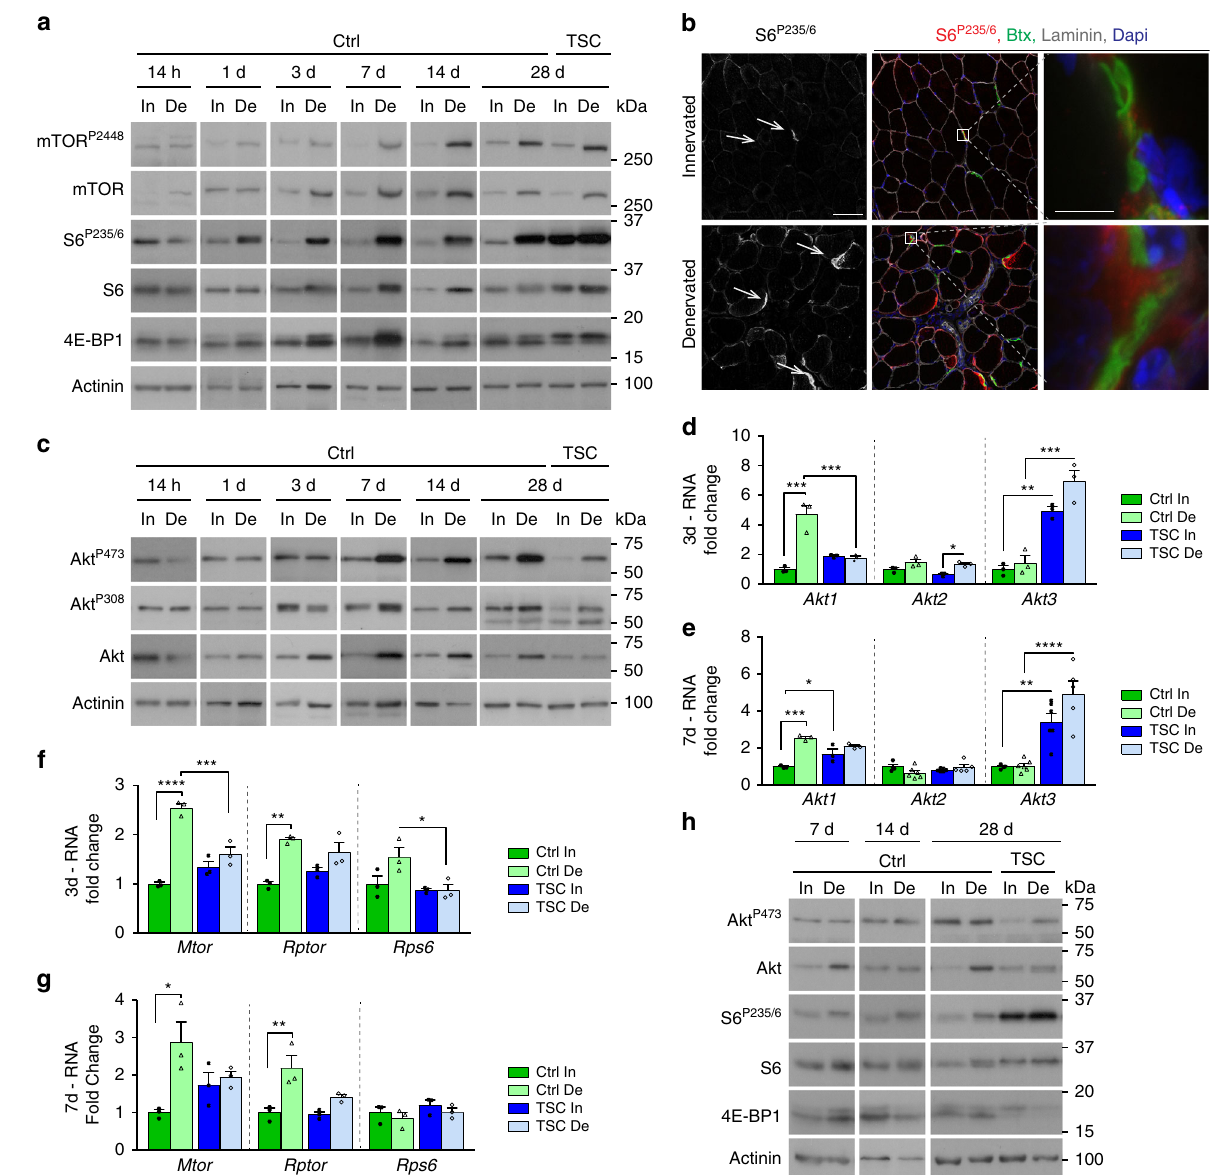
Fig. 1 The PKB/Akt-mTORC1 branch is induced upon denervation in TA muscle. a Western blot analysis of mTORC1 signaling in control (Ctrl) and TSCmKO (TSC) TA innervated (In) and denervated (De) muscles. Actinin was used as loading control. Representative image of 4 (14 h, 1d) and 3 (3 to 28d) Ctrl and 3 TSCmKO mice. b Confocal images of S6 P235/6 (red), laminin (gray), α -bungarotoxin (green) and Dapi (blue) in TA innervated and denervated muscles (four independent assays). The white arrows point to endplates. Scale bar, 50 µ m (5 µ m for enlarged view). c Western blot analysis of total and phosphorylated PKB/Akt in control and TSCmKO TA innervated and denervated muscles. Actinin was used as loading control. Representative image of 4 (14 h to 3d) and 3 (14 and 28d) Ctrl and 3 TSCmKO mice. d – g mRNA levels of Akt1 , Akt2 and Akt3 ( d , e ) and Mtor , Rptor and Rps6 ( f , g ) in TA innervated muscle and after 3 ( d , f ) and 7 ( e , g ) days of denervation, in TSCmKO and control mice. Levels are relative to Tbp mRNA and to Ctrl innervated muscle. Values are mean ± s.e.m.; n = 4 – 6 ( Akt2/Akt3 ) and 3 (all other genes) mice per genotype; * p < 0.05, ** p < 0.01, *** p < 0.001, **** p < 0.0001, two- way ANOVA with a Tukey ’ s post-hoc analysis. h Western blot analysis of PKB/Akt and mTORC1 pathways in soleus control and TSCmKO muscles after